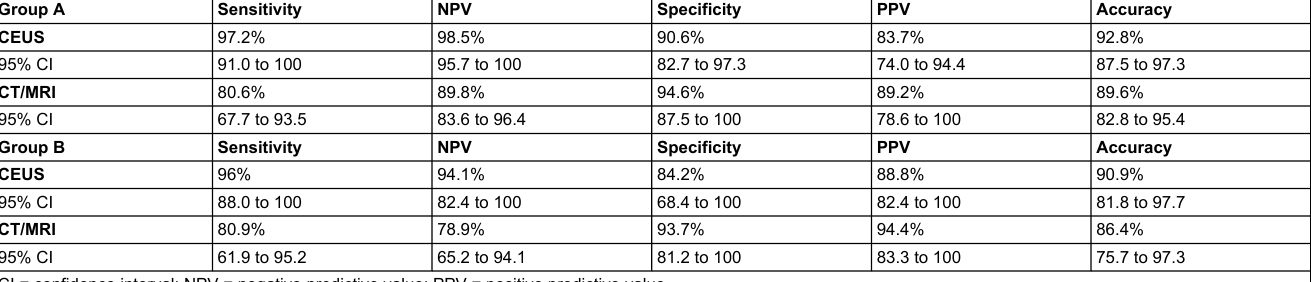
Table 4: Comparison of the diagnostic accuracy of contrast-enhanced ultrasound (CEUS) versus computed tomography / magnetic resonance imaging (CT/MRI). Analysis of the imaging accuracy in patients with histology as the standard of reference (group A, n = 44). Accuracy of imaging techniques in all study patients (group B, n = 112). Group A